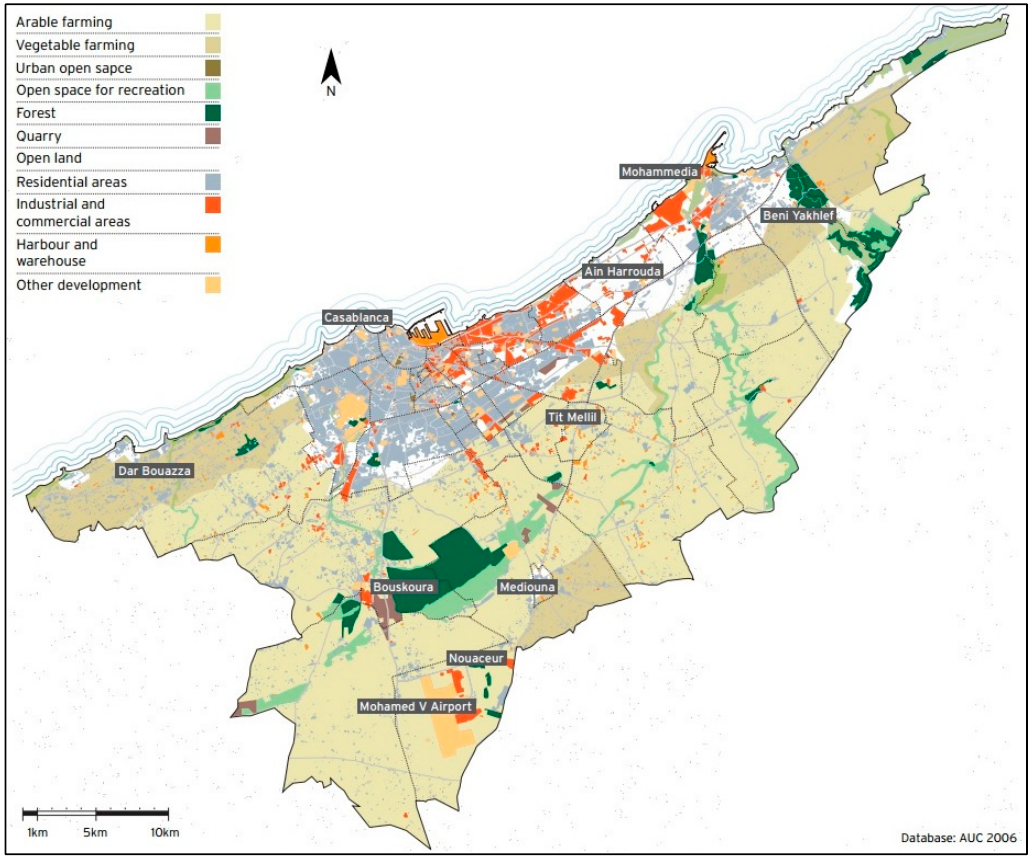
Figure 11. Land use of Casablanca region (Source: Urban Agency of Casablanca, 2006).